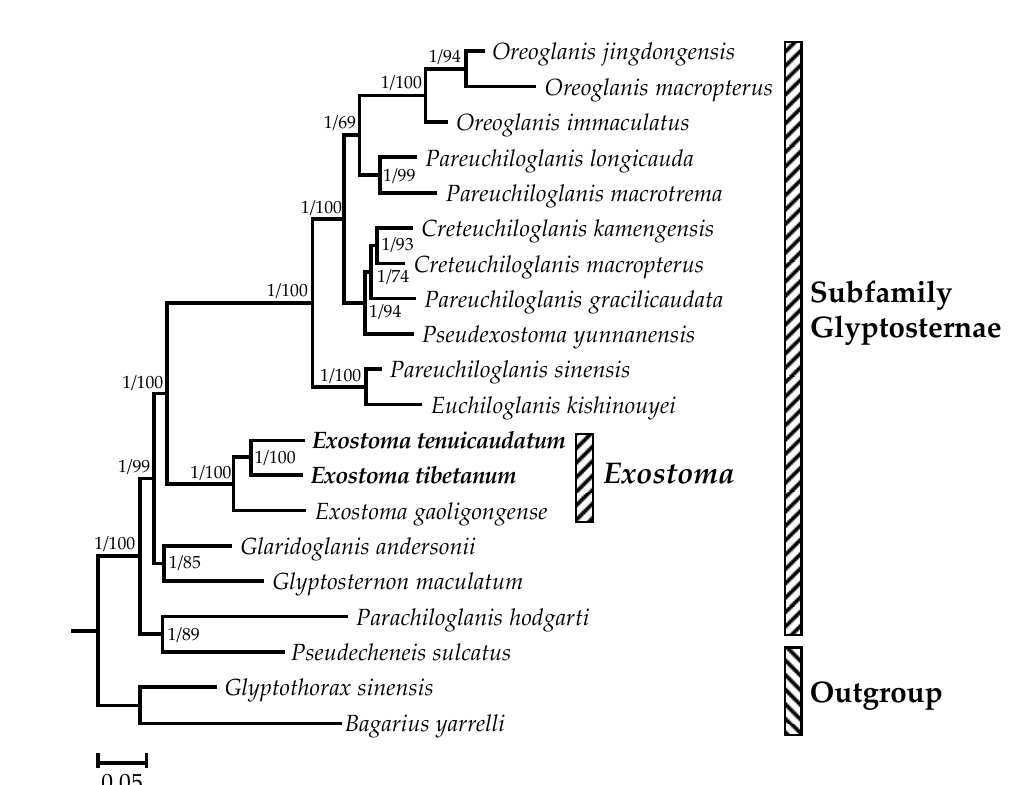
Figure 4. The phylogenetic trees constructed based on 13 protein-coding genes using Bayesian inference and maximum likelihood methods. Bayesian percent posterior probabilities and maximum likelihood bootstrap values are indicated at each node in the tree, separated by ‘/’.